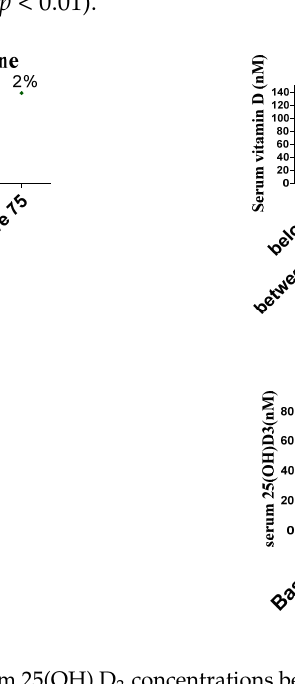
Figure 3. Serum 25(OH) D 3 concentrations before and after vitamin D 3 supplementation. ( a ) Baseline levels, ( b ) day 1 levels, and ( c ) day 30 levels. ( d ) Columns represent medians of serum 25(OH)D 3 , and error bars indicate interquartile range. Data were analyzed by non-parametric repeated measure ANOVA followed by Wilcoxon signed-rank multiple comparison test. *** p < 0.001, ** p < 0.01.